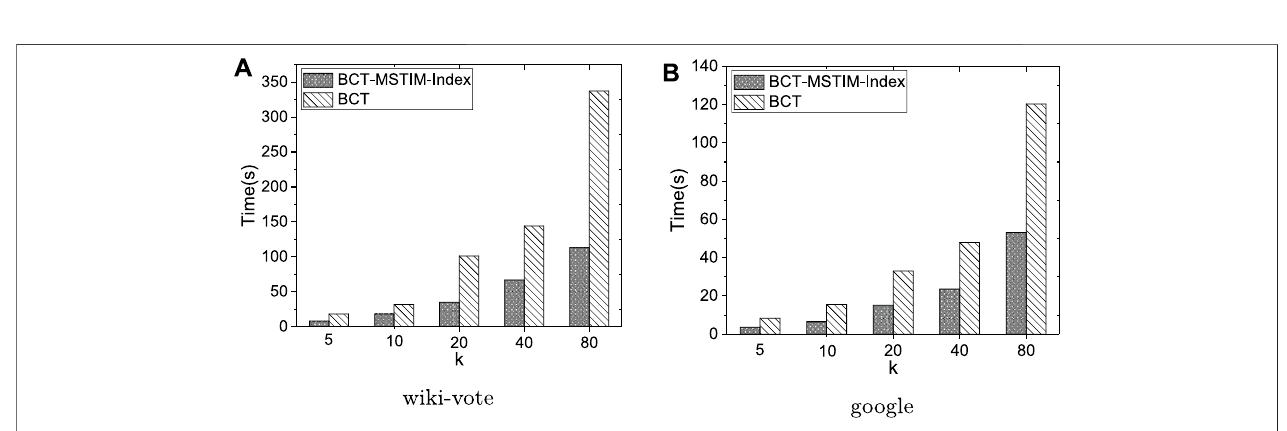
FIGURE8| TheaveragetimecostofBCTbasedtargetedin fl uencemaximizationalgorithmforevaluatingtherandomlygeneratedquerygroupsovertwodatasets.